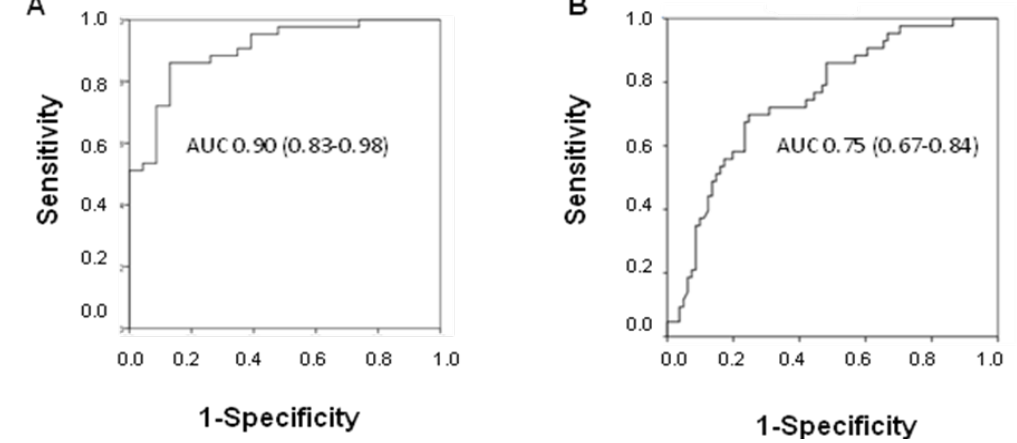
Figure 3. Diagnostic potential of free circulating DNA in discriminating between non-small cell lung cancer patients and ( A ) healthy donors, or ( B ) individuals with other